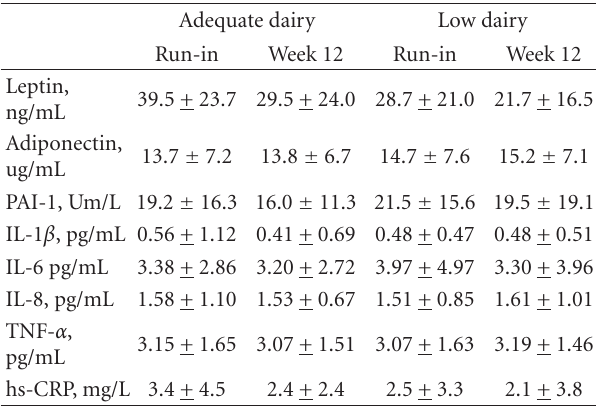
Values are mean + SD. IL: interleukin; TNF: tumor necrosis factor; hsCRP: high-sensitivity C- reactive